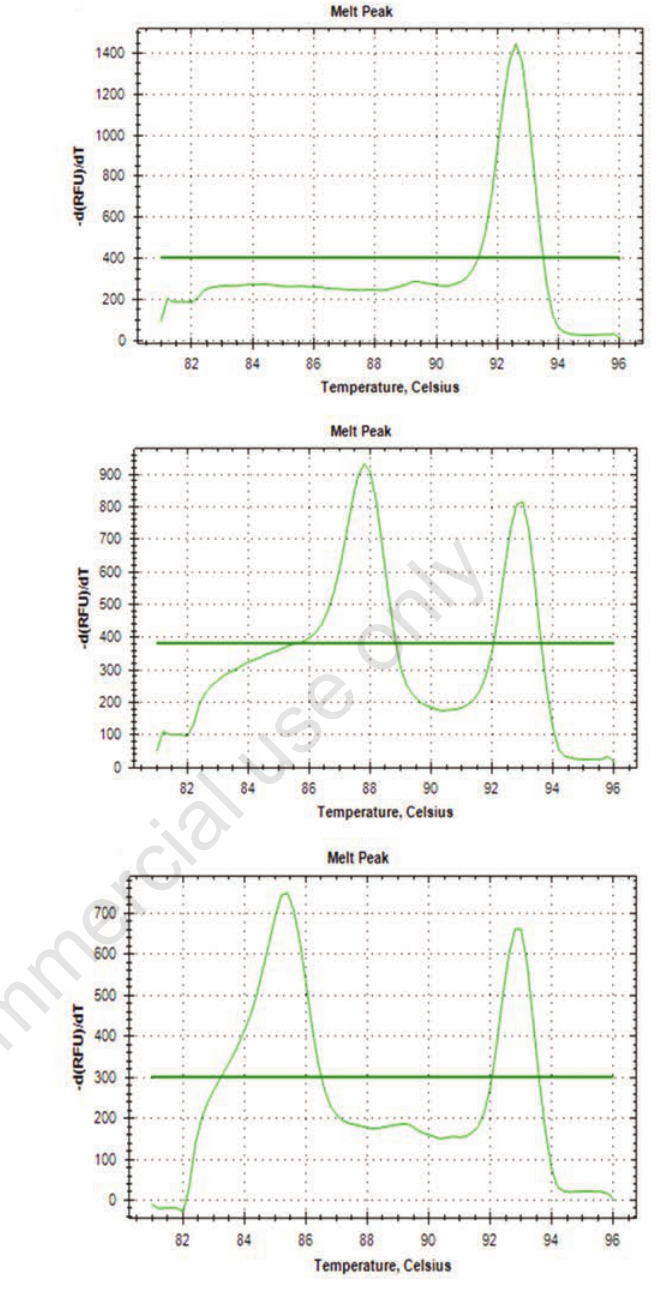
Figure 1. Here shows chromatograms using the quantitative real-time PCR. The control wild type DNA show only an image of single melt peak with a melting point of 92.4 °C (A) while SEA and Thai trait demonstrated the double melt peaks with melting points of 87.4 °C with 92.4 °C (B) and 85.4 °C with 92.4 °C (C),